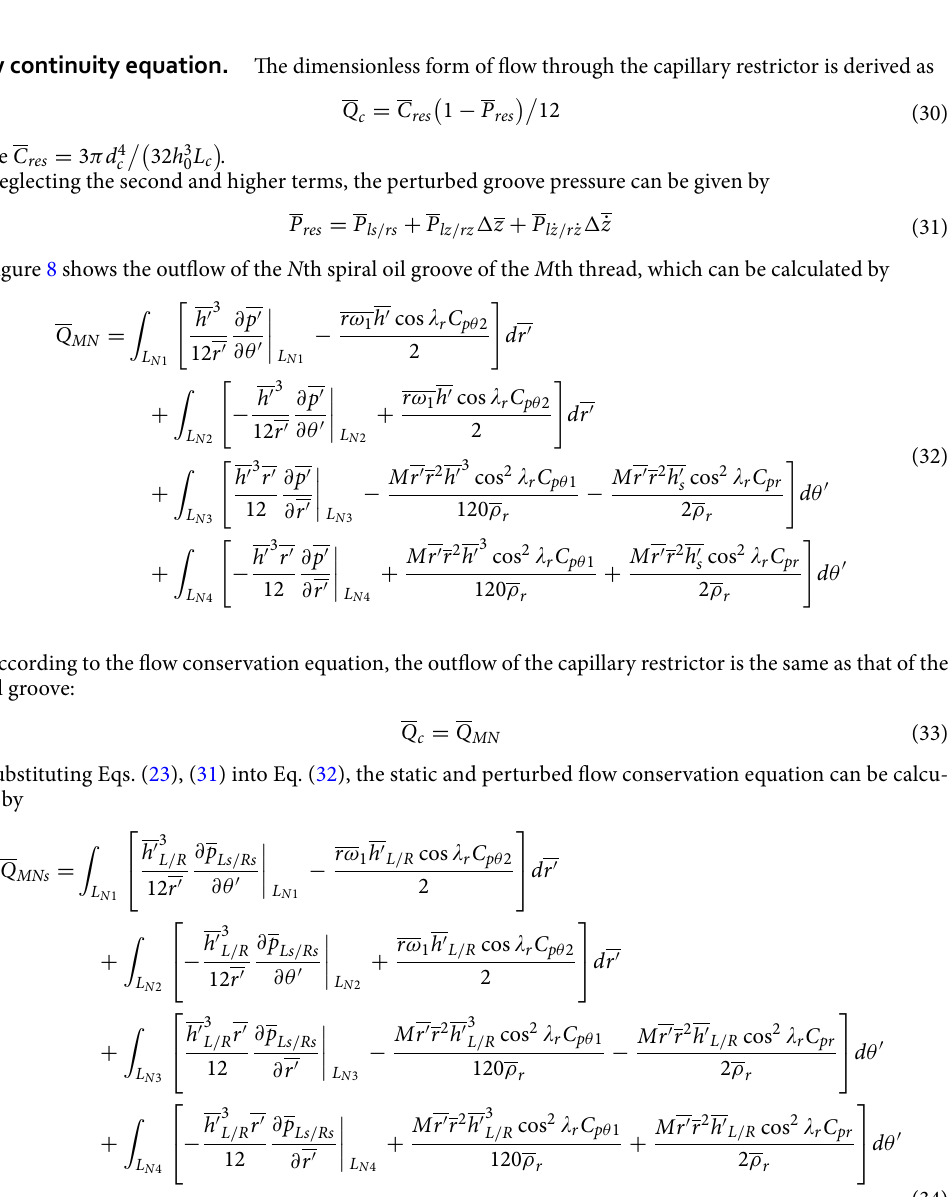
Figure 8. Outflow diagram of the